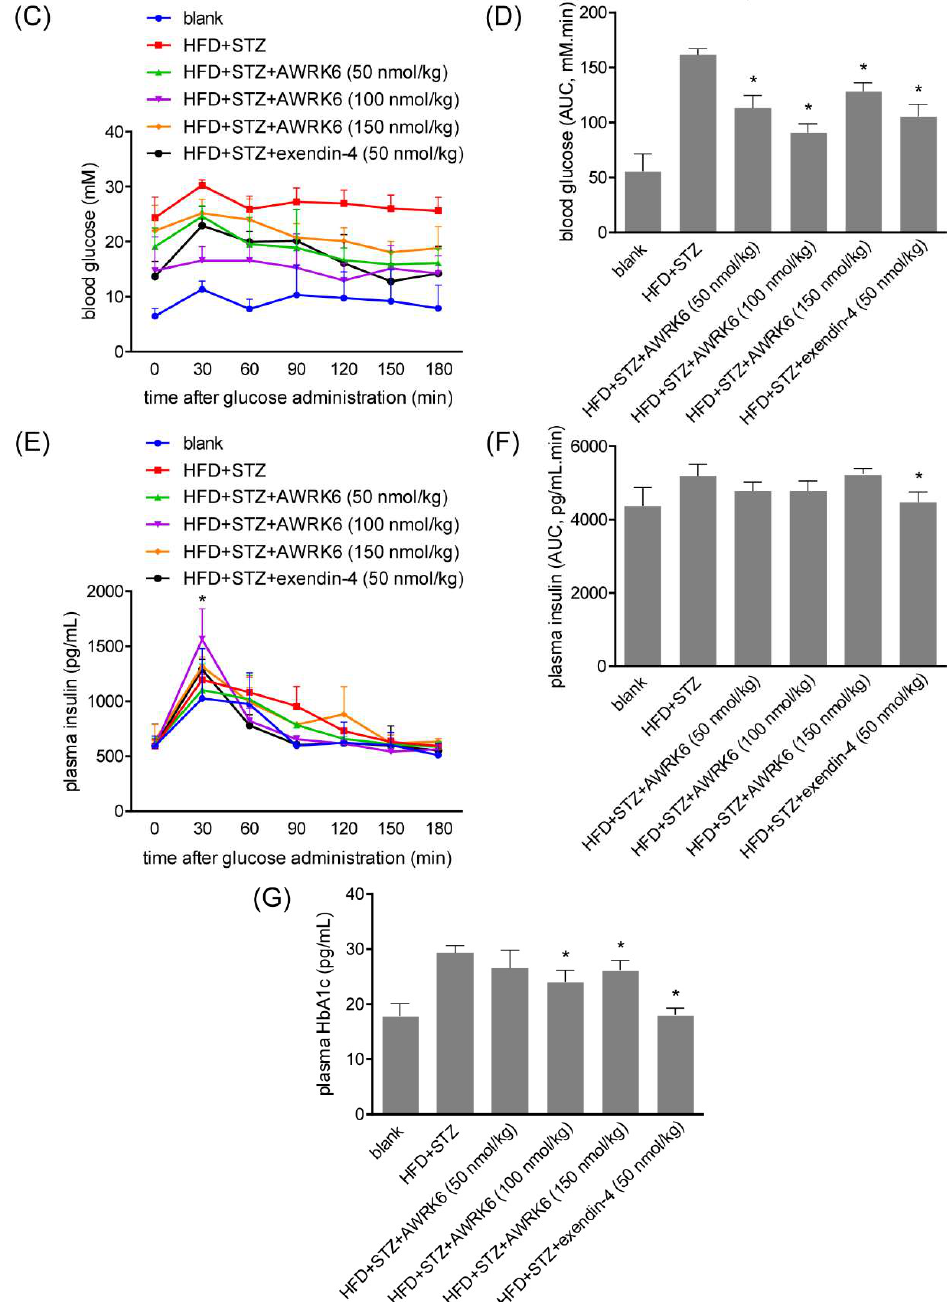
Figure 1. AWRK6 reduced blood glucose in diabetic mice. ( A ) The fasting blood glucose (FBG) in diabetic mice (high-fat diet (HFD) + streptozocin (STZ)) treated with AWRK6 during 4 weeks, detected by a glucometer. ( B ) The AUC (area under the curve) analysis of AWRK6 on fasting blood glucose of diabetic mice during 4 weeks. ( C ) The blood glucose in diabetic mice treated with AWRK6 for 4 weeks in an oral glucose tolerance test (OGTT), detected by a glucometer during 180 min. ( D ) The AUC analysis of the results of OGTT during 180 min. ( E ) The plasma insulin in diabetic mice treated with AWRK6 for 4 weeks in OGTT, detected by ELISA. ( F ) The AUC analysis of the results of plasma insulin in diabetic mice treated with AWRK6 for 4 weeks in OGTT. ( G ) The plasma HbA1c levels in diabetes mice after treatment with AWRK6 for 4 weeks, analyzed by ELISA. The error bar indicates standard deviation. * p < 0.05 compared with the diabetes groups.